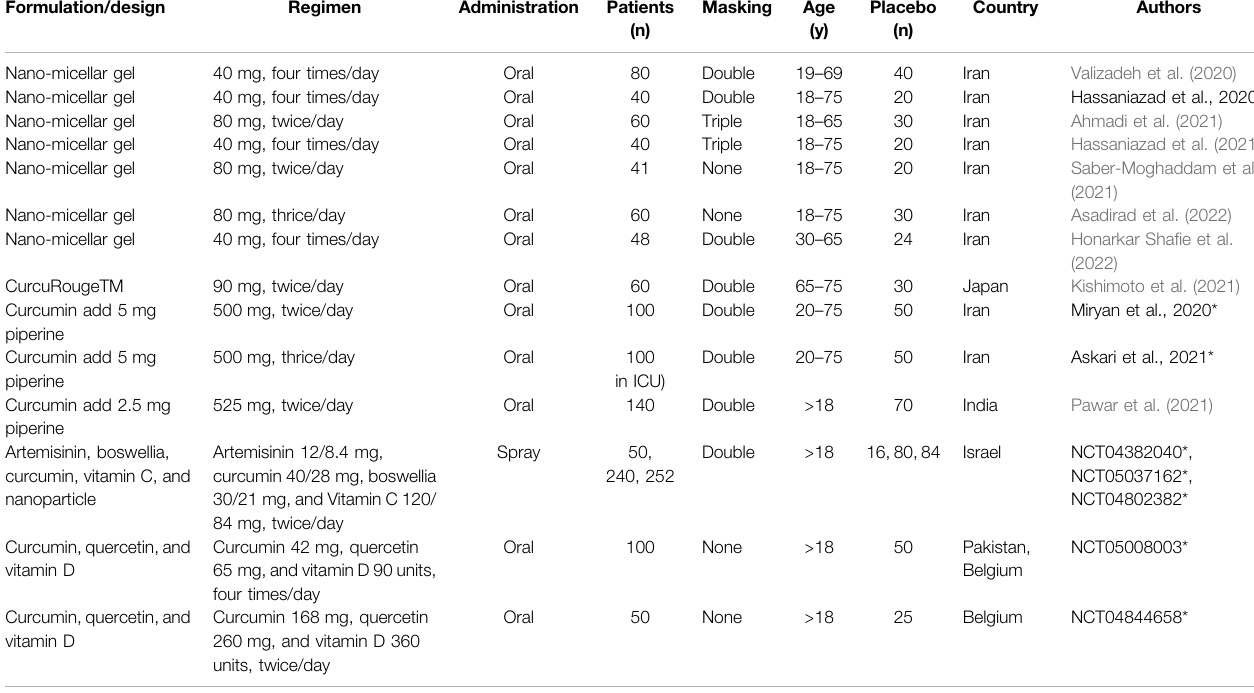
TABLE 2 | Clinical trial of curcumin on COVID-19 treatment of PubMed and ClinicalTrial.gov.